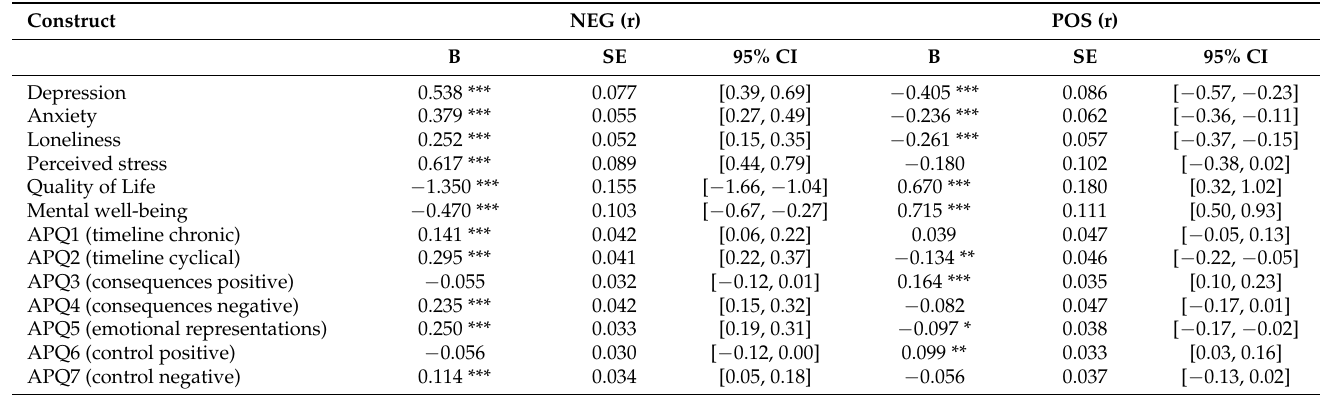
Table 7. Unmediated effects of perceived negative (NEG) and positive (POS) ageism scores on (mental health) outcome variables, and their relationships with different dimensions of self-perceptions of aging.